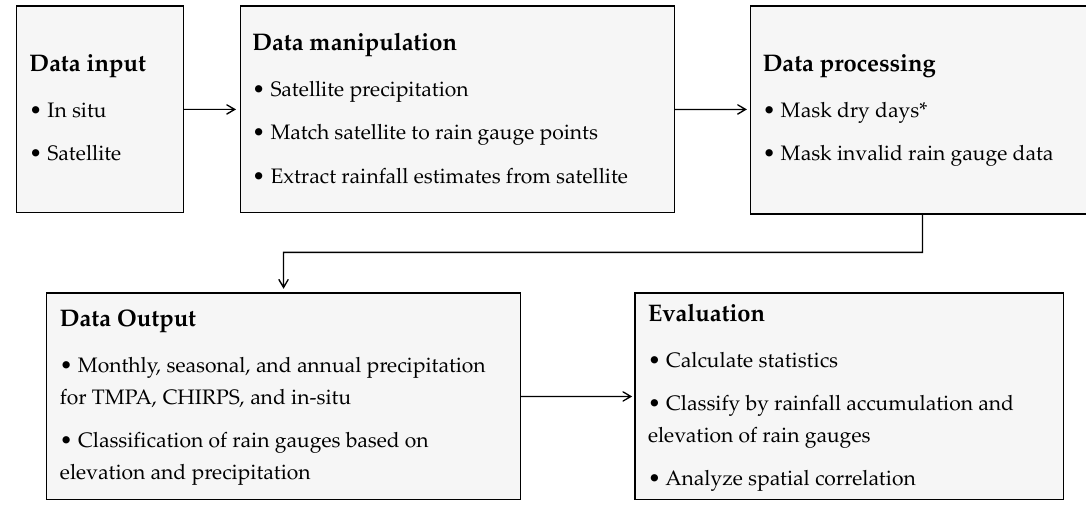
Figure 2. Methodology and workflow for this study. *Dry days are days where both satellite-based estimate and rain gauge measurement give a precipitation below the threshold of 0.06 mm. Dry days are excluded in some analyses but not all.